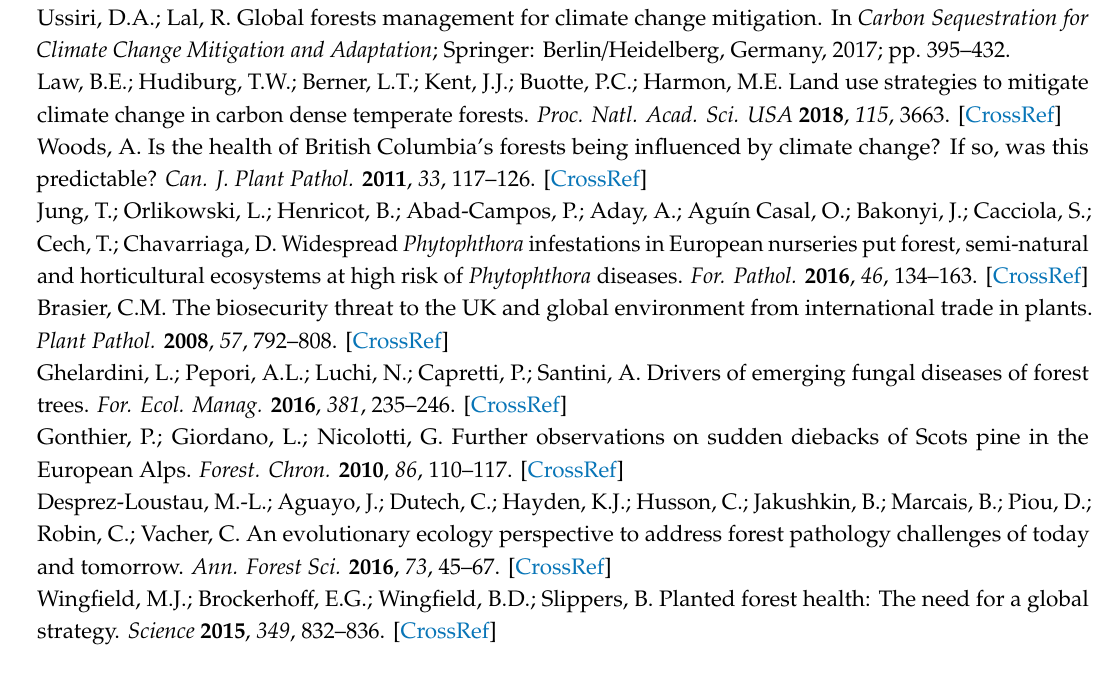
Figure S1: Phylogeny of ten New Zealand and five global isolates of Dothistroma septosporum, Figure S2: Evidence for duplication and deletion in Dothistroma septosporum genomes, Figure S3: Assessing long term trends in Dothistroma needle blight severity in New Zealand forests, Table S1: Single Nucleotide Polymorphisms in the D. septosporum genomes, Table S2: Mutation rates, Table S3: Nested ANOVA and e ff ect size analysis to test the null hypothesis of no e ff ect of decade group on phenotype, Table S4: Phenotype data for D. septosporum isolates, Table S5: D. septosporum NZE10 curated repeats over 200